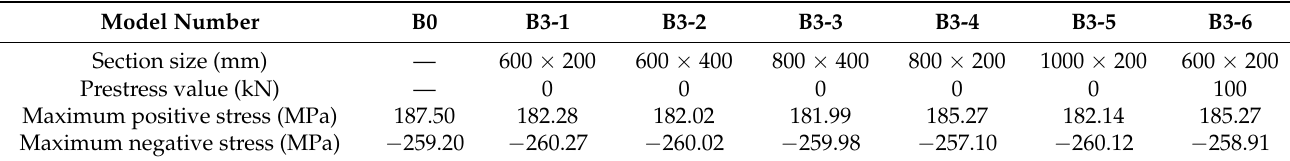
Table 11. Model C3 parameter adjustment.